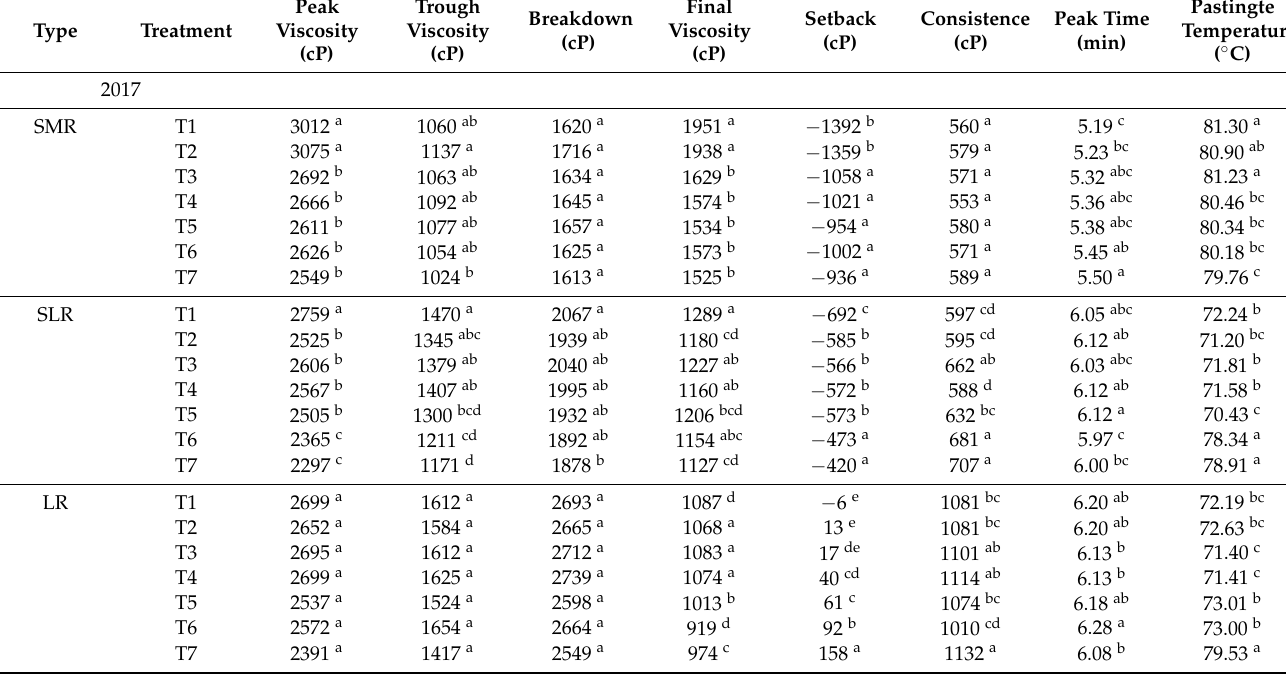
Table 6. Influence of T and R on RVA parameters of different types of rice 1